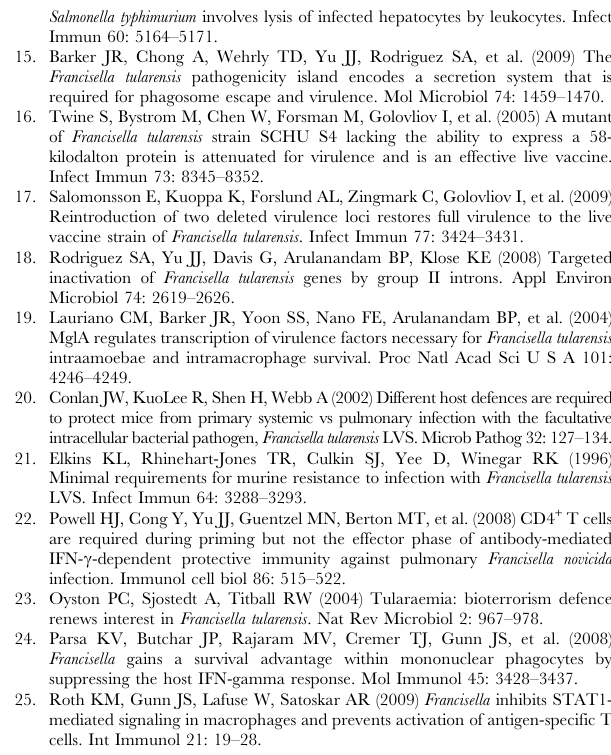
Table S2 Enzymatic characterization of wildtype U112 and fopC mutant using the API-ZYM kit. * Intensity of the color reactions was graded from 0 to 5 according to an API-ZYM color reaction chart.